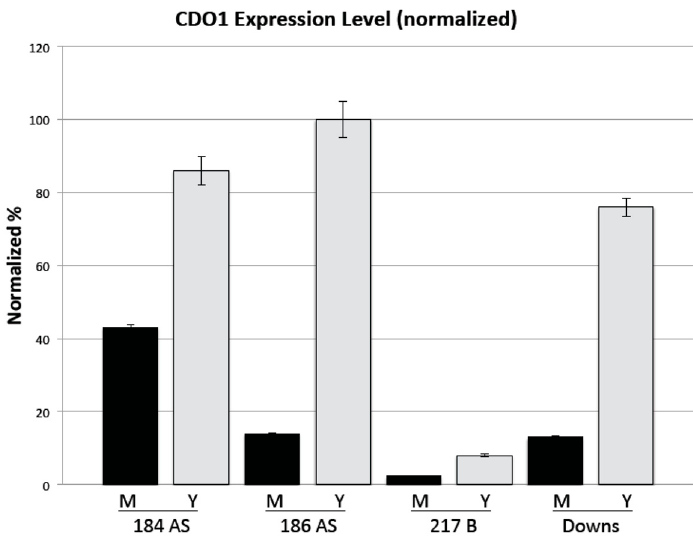
Figure 2. CDO1 expression determined by quantitative PCR. M, Mold; Y, Yeast. Expression was normalized to 186AS yeast = 100%. Error bars are the standard error of the mean of triplicate independent experiments.